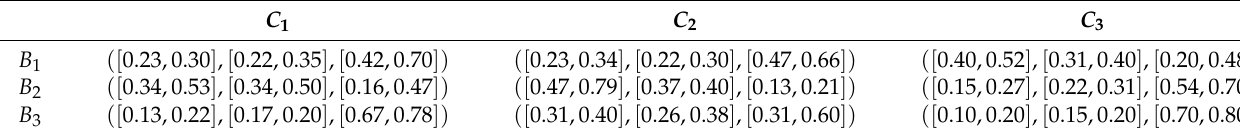
Table 2. The criteria of edge servers in Example 3.